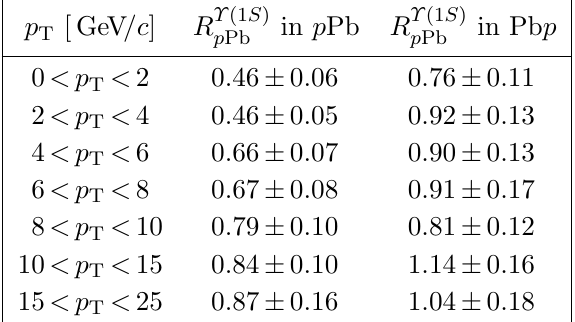
, in p Pb and Pb p as a function of p T integrated p Pb